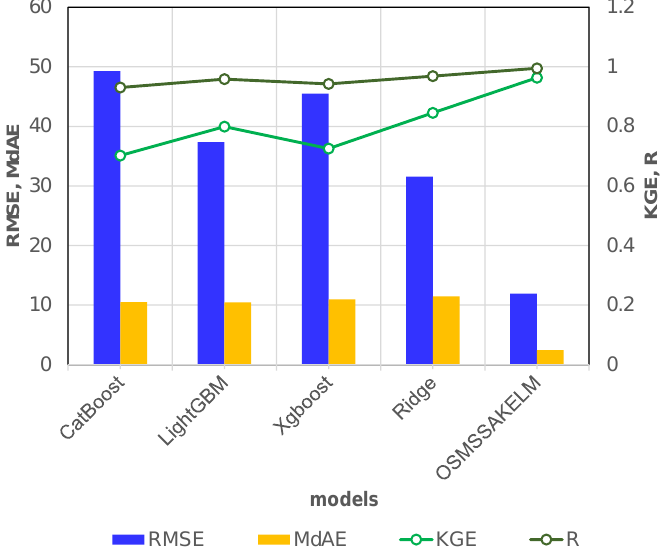
Figure 21. Comparison of the proposed model for the testing phase versus other studied models based on the RMSE, MdAE, KGE, and R